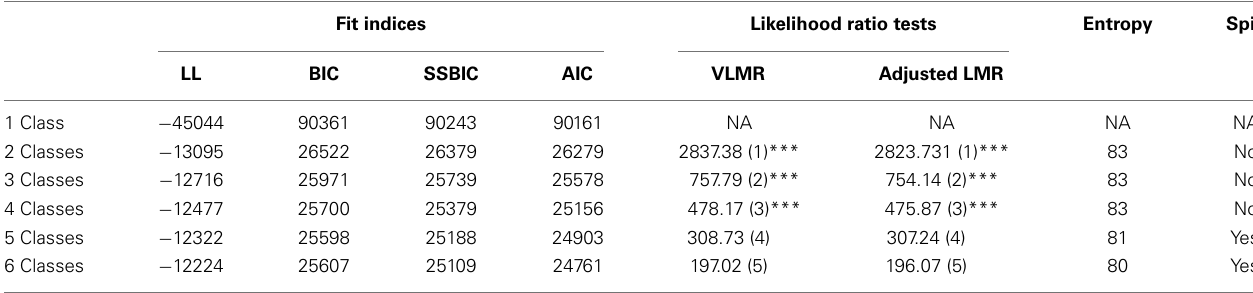
Table 2 | Fit statistics, likelihood ratio tests, and entropy for different class